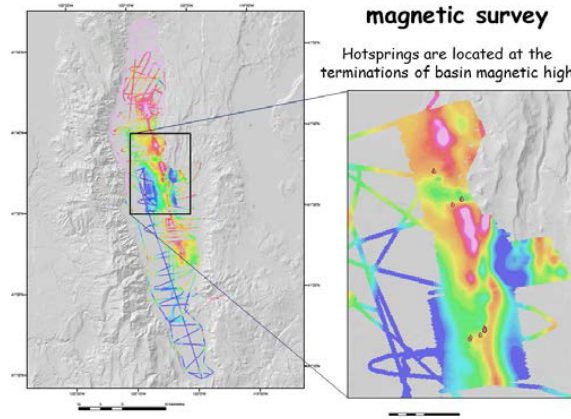
Figure 3. Magnetic grid derived from data collected by UAS in Surprise Valley, 2012. Hot springs shown as red